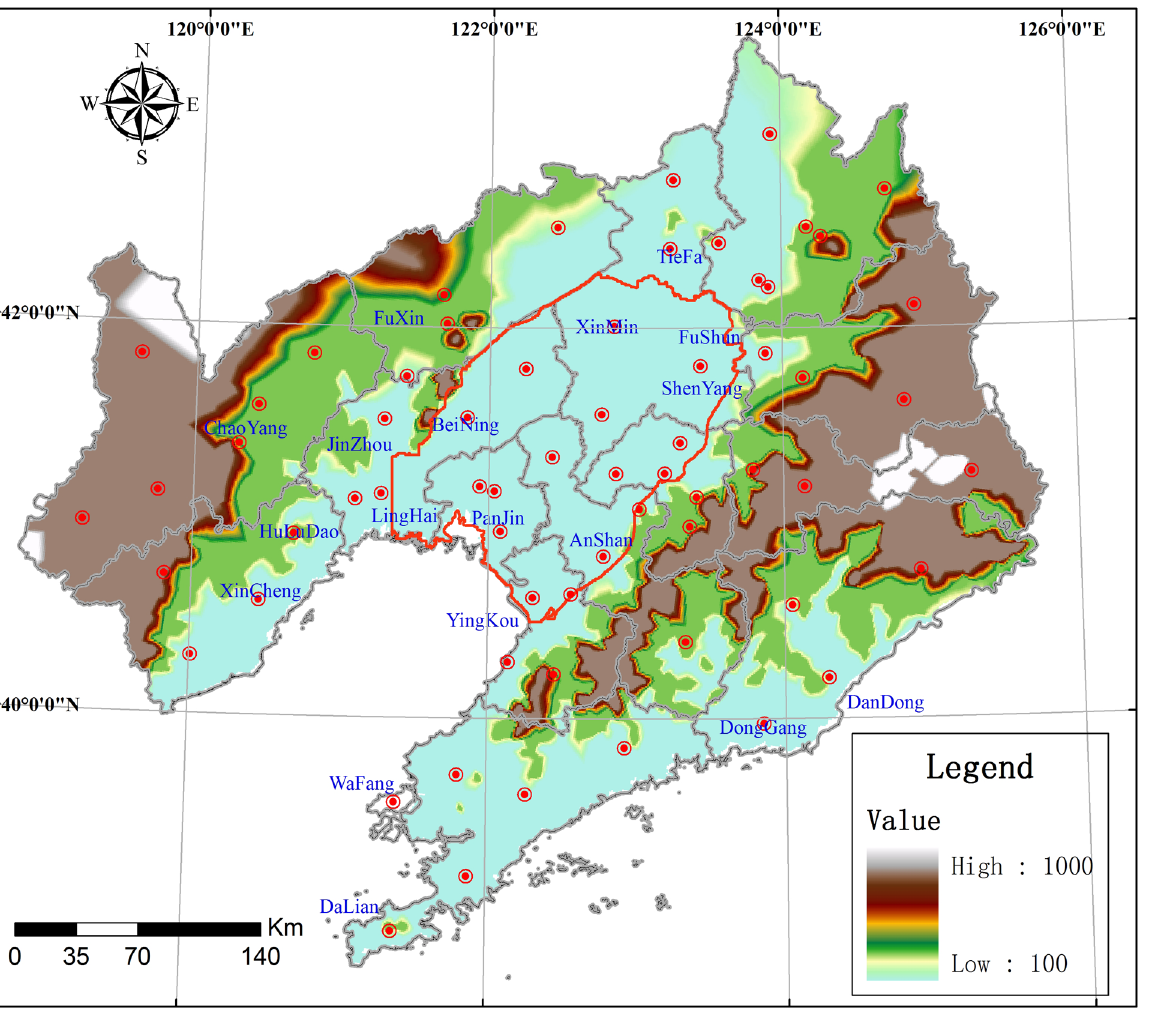
Fig 1. Location of the study